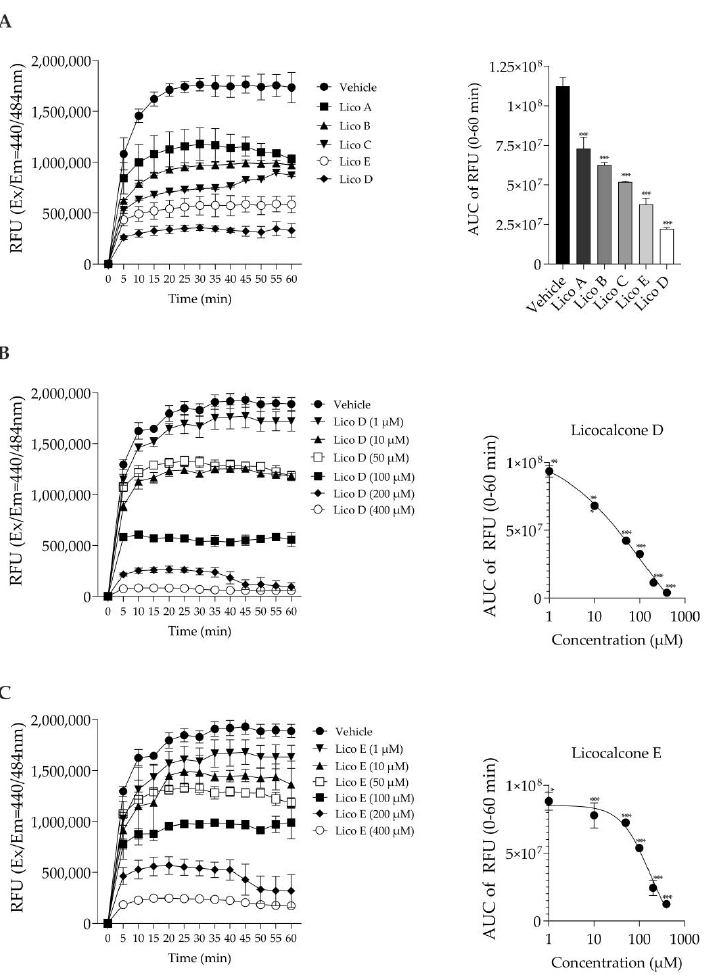
Figure 2. Effect of Licos A, B, C, D and E on Aβ1 -42 aggregation. The right-side figure is the AUC of the left-side figure. ( A ) The aggregation of Aβ1 -42 (213 µg/mL) in the absence or presence of Licos. The concentration of substances was 100 μ M. ( B ) The aggregation of Aβ1 -42 in the absence or presence of Lico D. ( C ) The aggregation of Aβ1 -42 in the absence or presence of Lico E. The AUC data were fitted to non-linear regression analysis. Values are the mean ± SD ( n = 3 samples/group). * p < 0.05, ** p < 0.005 and *** p < 0.0005 vs. vehicle control. Statistical analysis of the data was performed using Dunnett’s multiple comparisons test .